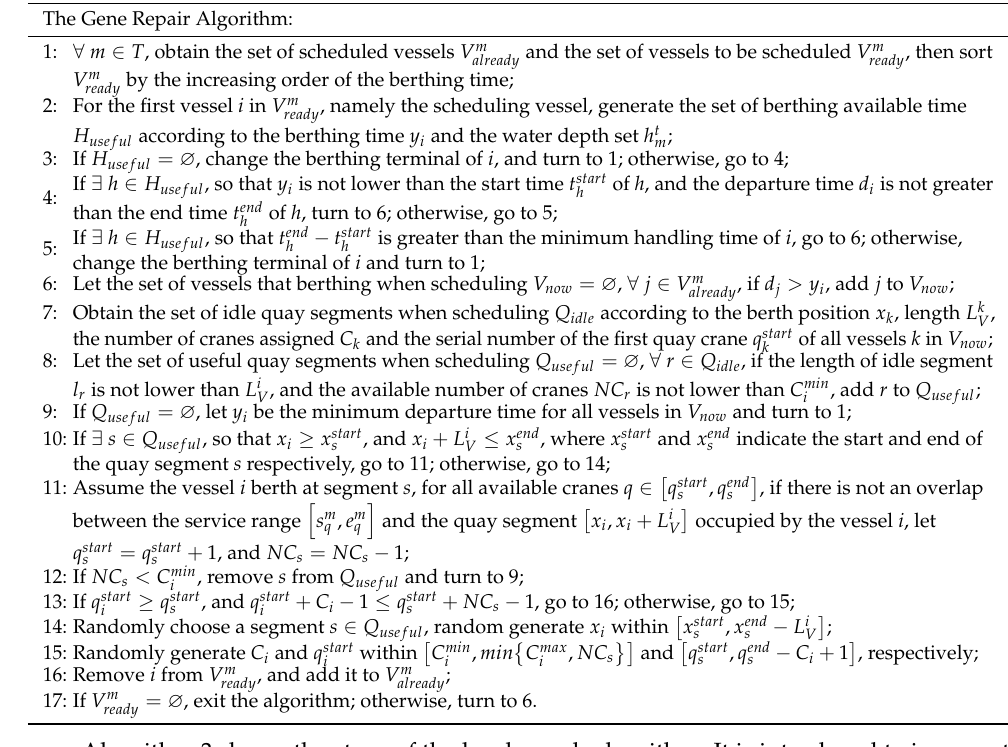
Algorithm 2 . Steps of the gene repair algorithm (Source: compiled by authors).